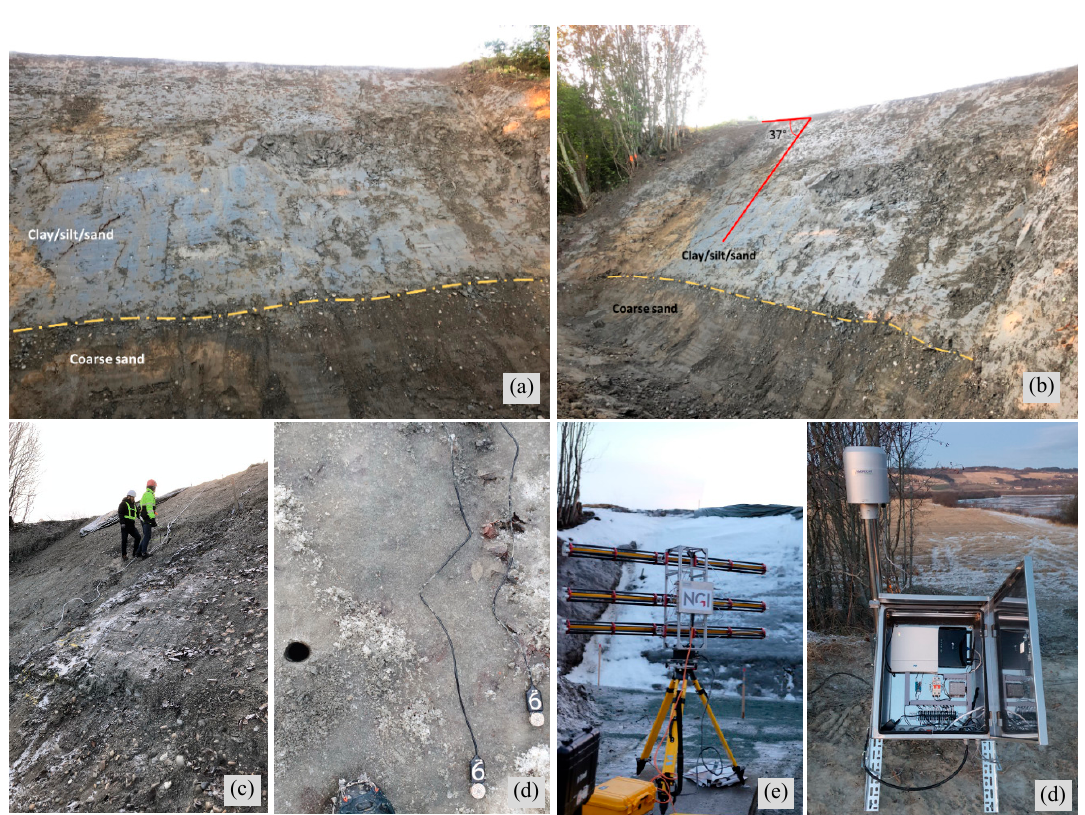
Figure 11. Test slope at Øysand Trondheim Norway: ( a ) 37 degree man-made test slope; ( b ) Layers of test slope; ( c ) inclinometer installation; ( d ) MPS-6 sensors; ( e ) Lidar system; ( f ) data logger box.